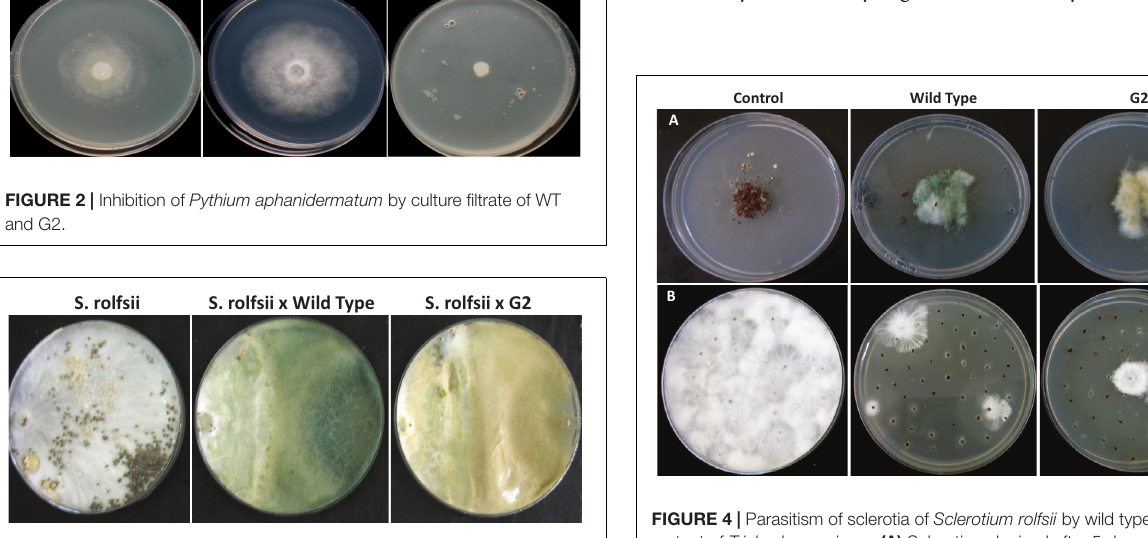
FIGURE 3 | Confrontation assay between Sclerotium rolfsii and Trichoderma virens mutant/wild-type strain.